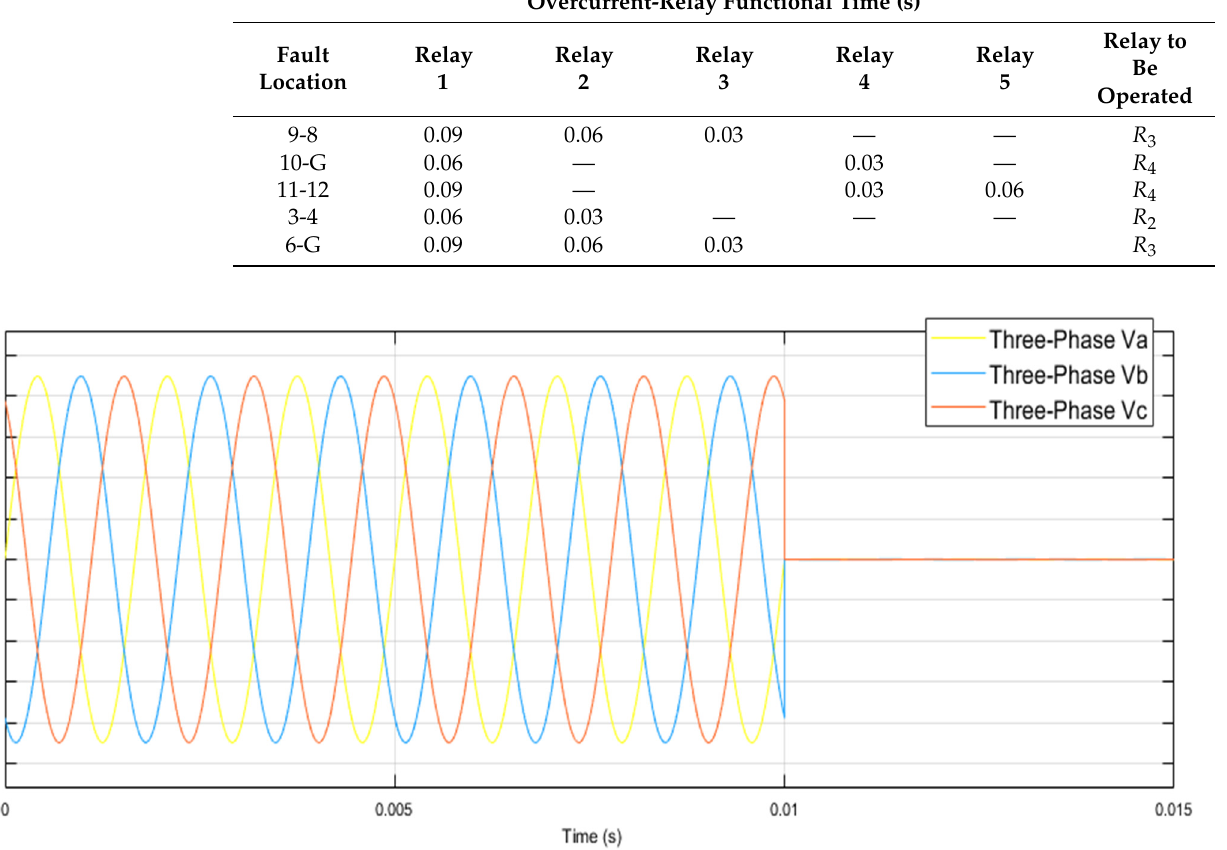
Table 4. Functional times of the overcurrent relays at different fault conditions.